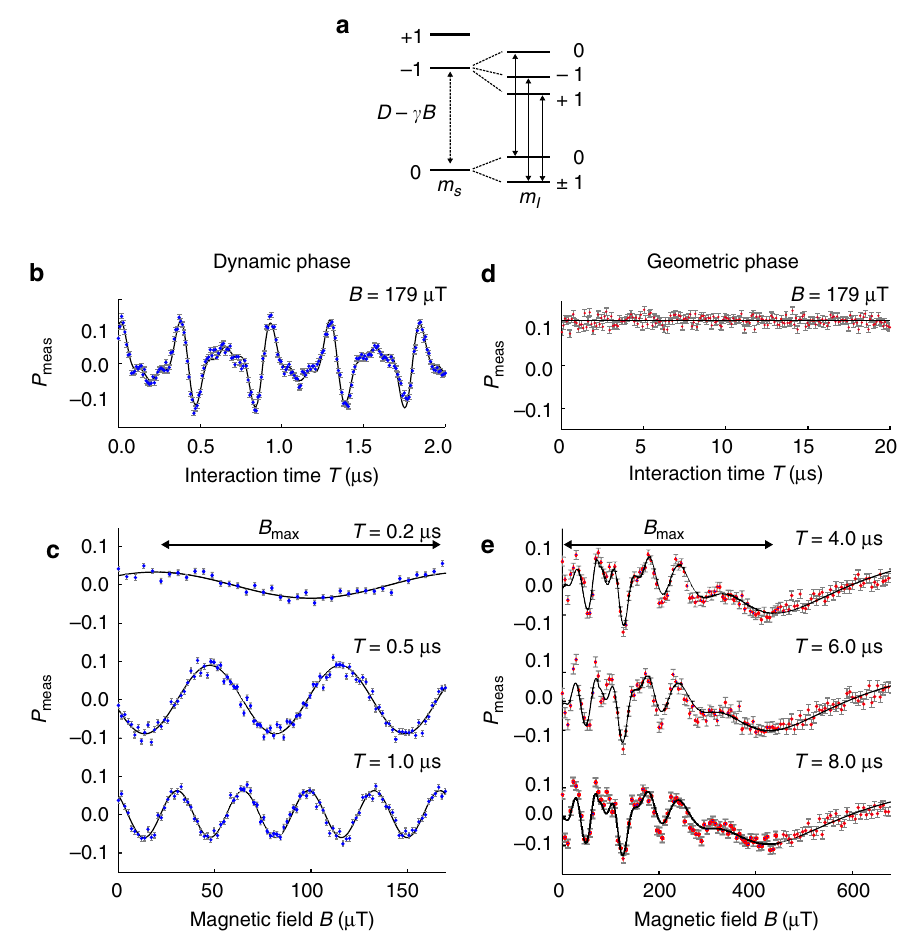
Fig. 2 Demonstration of dynamic- and geometric-phase magnetometry using a single NV spin in diamond. a NV electronic spin ( S = 1) has sublevels m s = 0 and ± 1 with zero- fi eld splitting D = 2 π × 2.87 GHz. An external magnetic fi eld B introduces Zeeman splitting between the m s = ± 1 states with gyromagnetic ratio γ = 2 π × 28 GHz T − 1 . m s = 0 and − 1 de fi ne the two-level system used in this work. Hyper fi ne interactions with the host 14 N nuclear spin lead to m I = 0, ± 1, split by ±2.16MHz. b − e Blue and red dots represent measured magnetometry data for dynamic phase ( b , c ) and geometric phase ( d , e ) protocols, respectively. Vertical axes give the measured optical signal P meas = ( Δ FL / FL ) × k , where Δ FL / FL is the fractional change of NV-spin-state- dependent fl uorescence and k is a constant that depends on NV readout contrast. Error bars are one standard deviation photon shot-noise. Black lines show fi ts to a model outlined in the main text. Blue- and red-shaded regions represent maximum magnetic fi eld ranges. Beating due to three hyper fi ne resonances is evident in b . In dynamic-phase magnetometry, the oscillation period decreases as the interaction time increases, indicating a trade-off between sensitivity and fi eld range ( c ). Geometric-phase magnetometry signal in ( d ) shows independence of T . Field range is de fi ned at the last